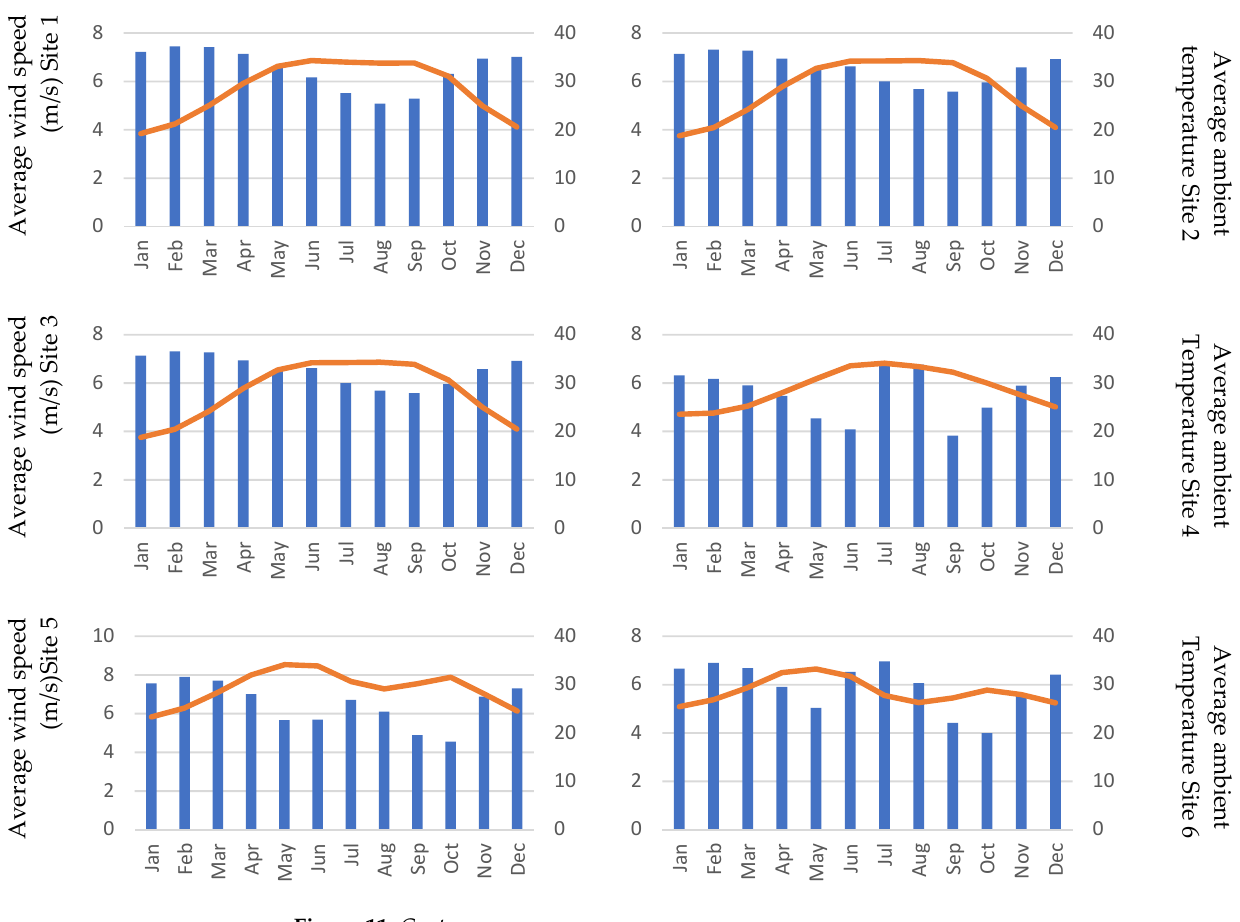
Figure 10. Daily solar radiation and clearness index for the 12 sites (the x -axis represents the month of the year, and the primary y -axis represents the daily radiation in kWh/m 2 /day; the secondary y -axis represents the clearness index).